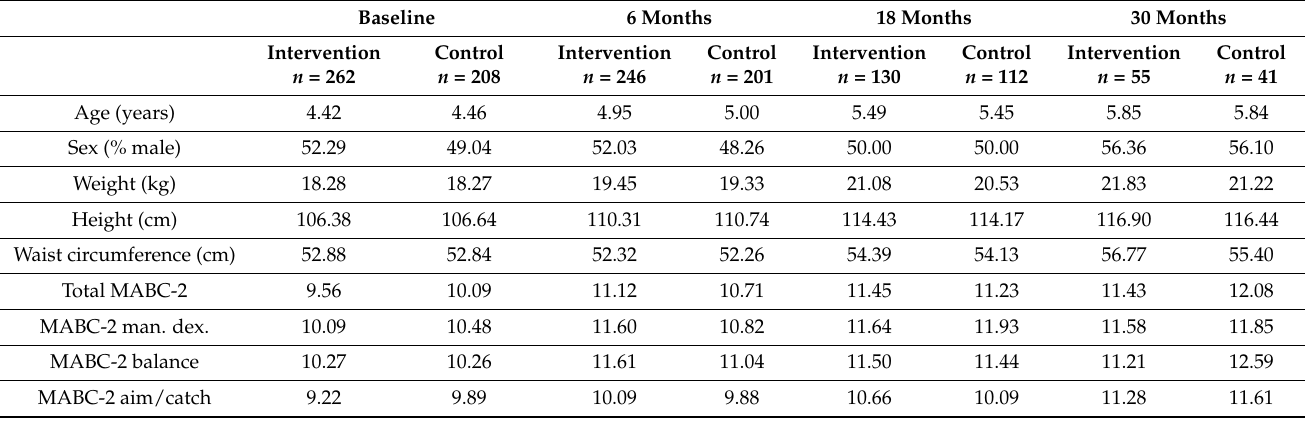
Table 4. Age, sex, anthropometry, and motor skills measures at baseline and all follow-up points by intervention group (% for sex, otherwise